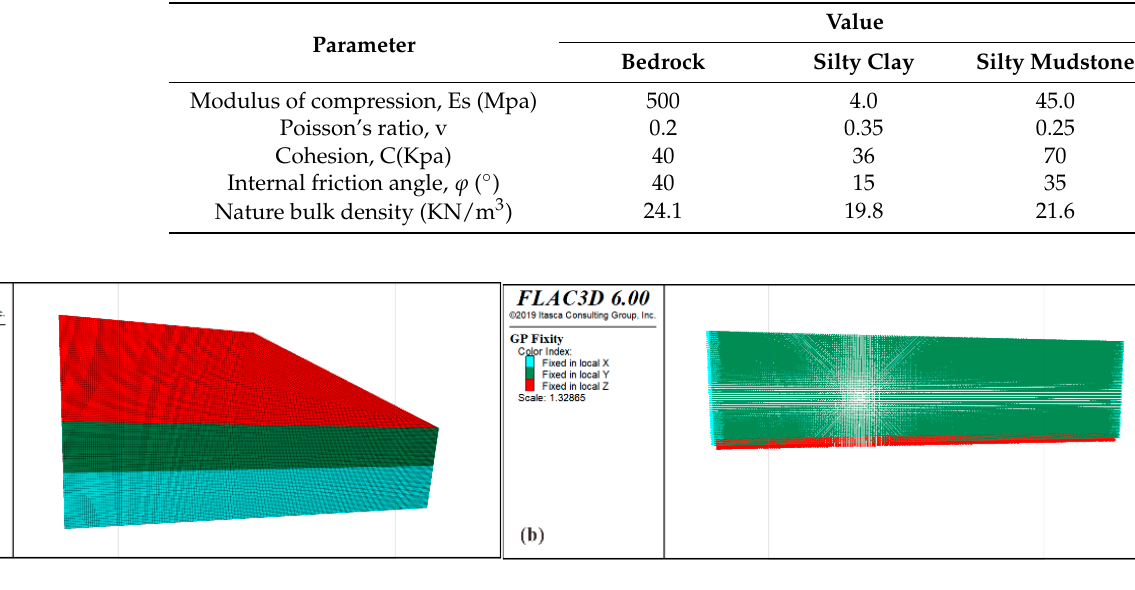
Figure 9. ( a ) Formation information; ( b ) boundary condition setting (set the initial velocity of X, Y, and Z). Table 3. Physical parameters of each layer.